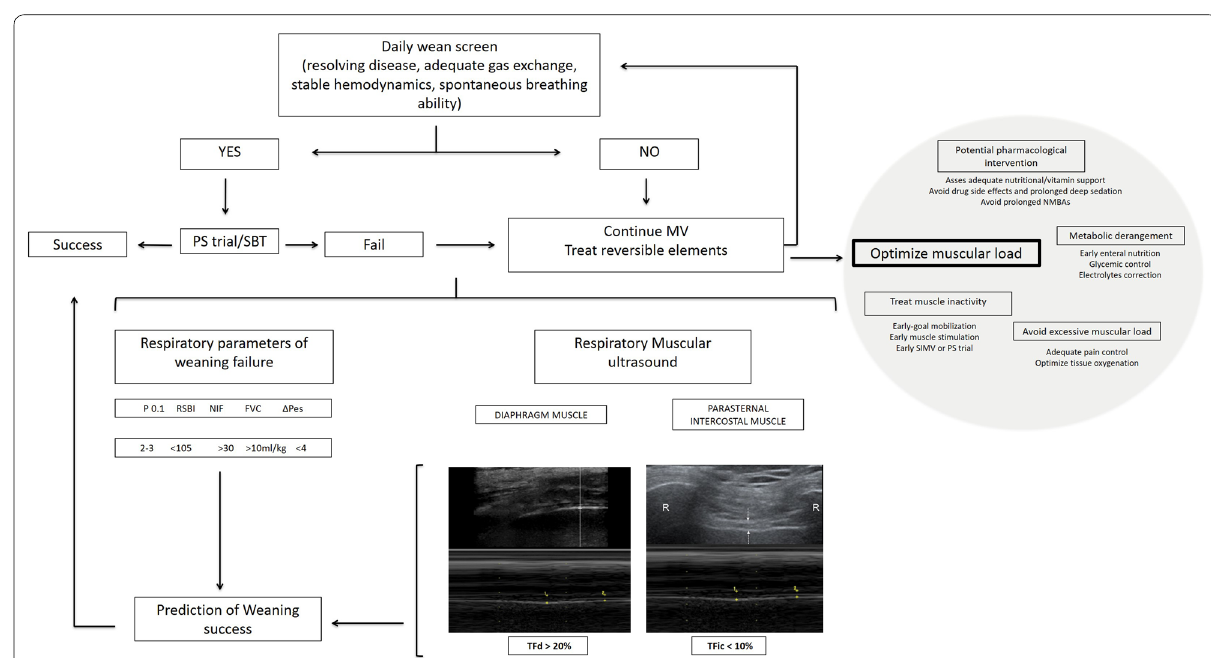
Fig. 3 A simplified diagram of respiratory muscular ultrasound during weaning trial from mechanical ventilation. Once a pressure support (PS) trial or a spontaneous breathing trial (SBT) is started and patients failed a termination of the weaning process within 24 h a diaphragm evaluation exploring the diaphragmatic thickening fraction (TFdi) should be performed. At the same time, the parasternal intercostal muscle should be evaluated. The simplest method is to evaluate the thickness and the thickening fraction (TFic) as calculated for the diaphragm (TF inspiration – TH end expiration)/TH end expiration)) * 100. A value of TFic less than 10%, associated with a TFdi greater than 20% indicates a pattern of breathing in which respiratory muscles are not recruited, and is then suggestive of a successful weaning trial. All these measurements should be integrated with other routinely used predictive parameters of weaning failure, such as rapid shallow breathing index (RSBI), negative inspiratory function (NIF), forced vital capacity (VFC) and the tidal change in esophageal pressure (Δpes). In any case, consider optimizing muscular load acting on pharmacological intervention, metabolic supply, and respiratory muscular